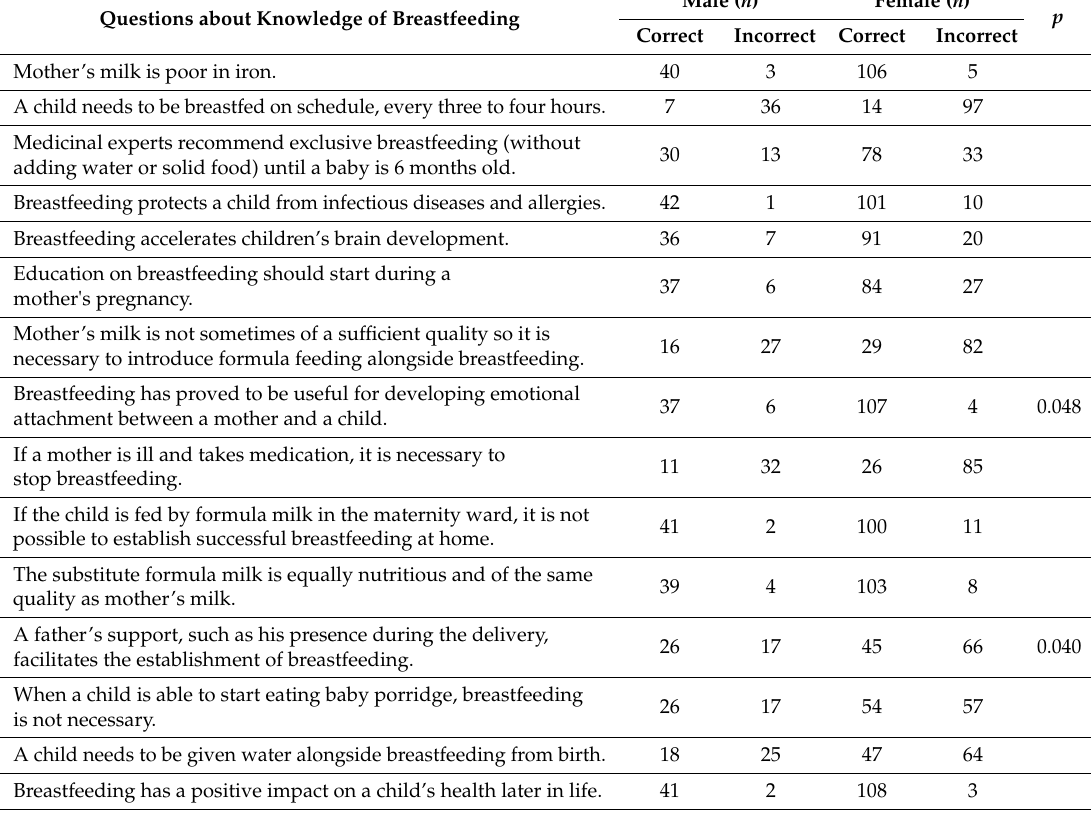
Table 3. The answers to the questions about knowledge of